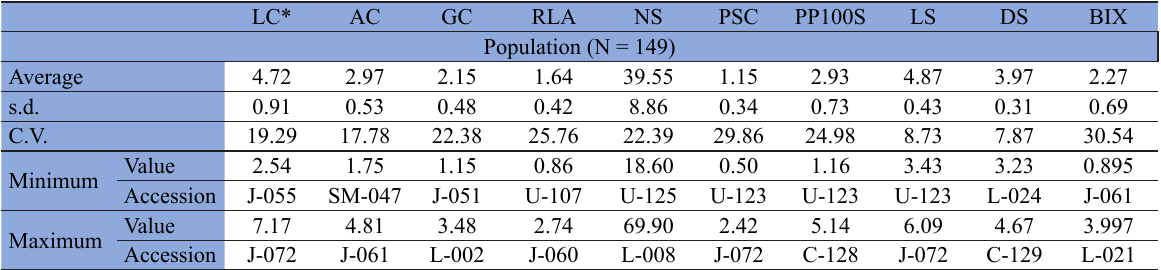
s.d.: Standard deviation; C.V.: Variability coefficient (%). *LC: Capsule length (cm); AC: Capsule width (cm); GC: Capsule thickness (cm); RLA: Capsule Length-width ratio; NS: Number of seeds per capsule; PSC: Seed weight per capsule (g); PP100S: weight of 100 seeds (g); LS: Seed length